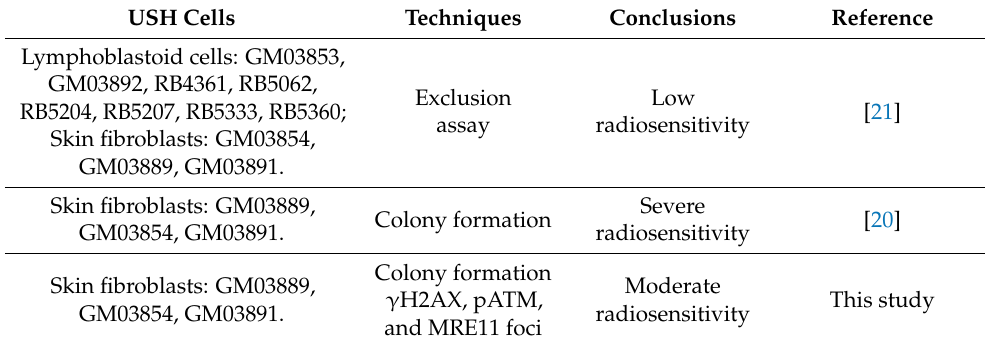
Table 1. Major studies dealing with the radiobiological characterization of USH cells. USH Cells Techniques Conclusions